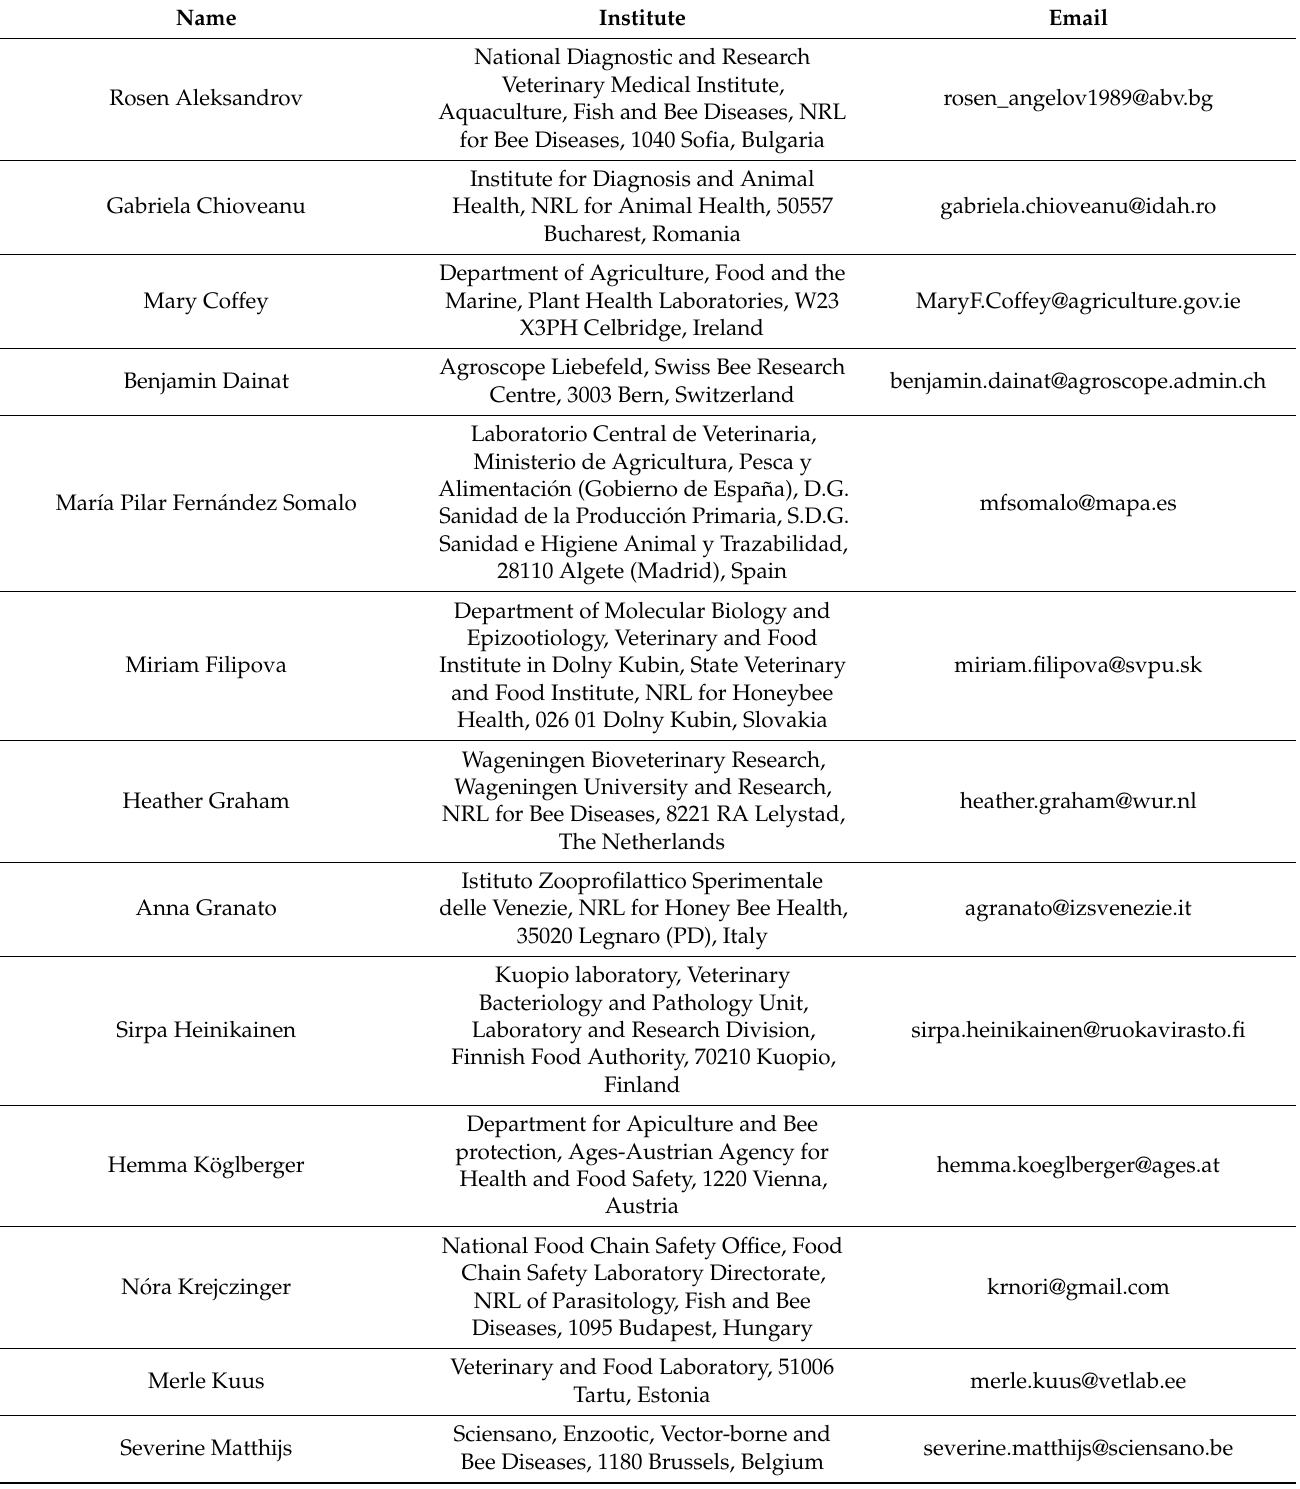
Table A4. Complete membership of the ILC Consortium (names listed in alphabetical